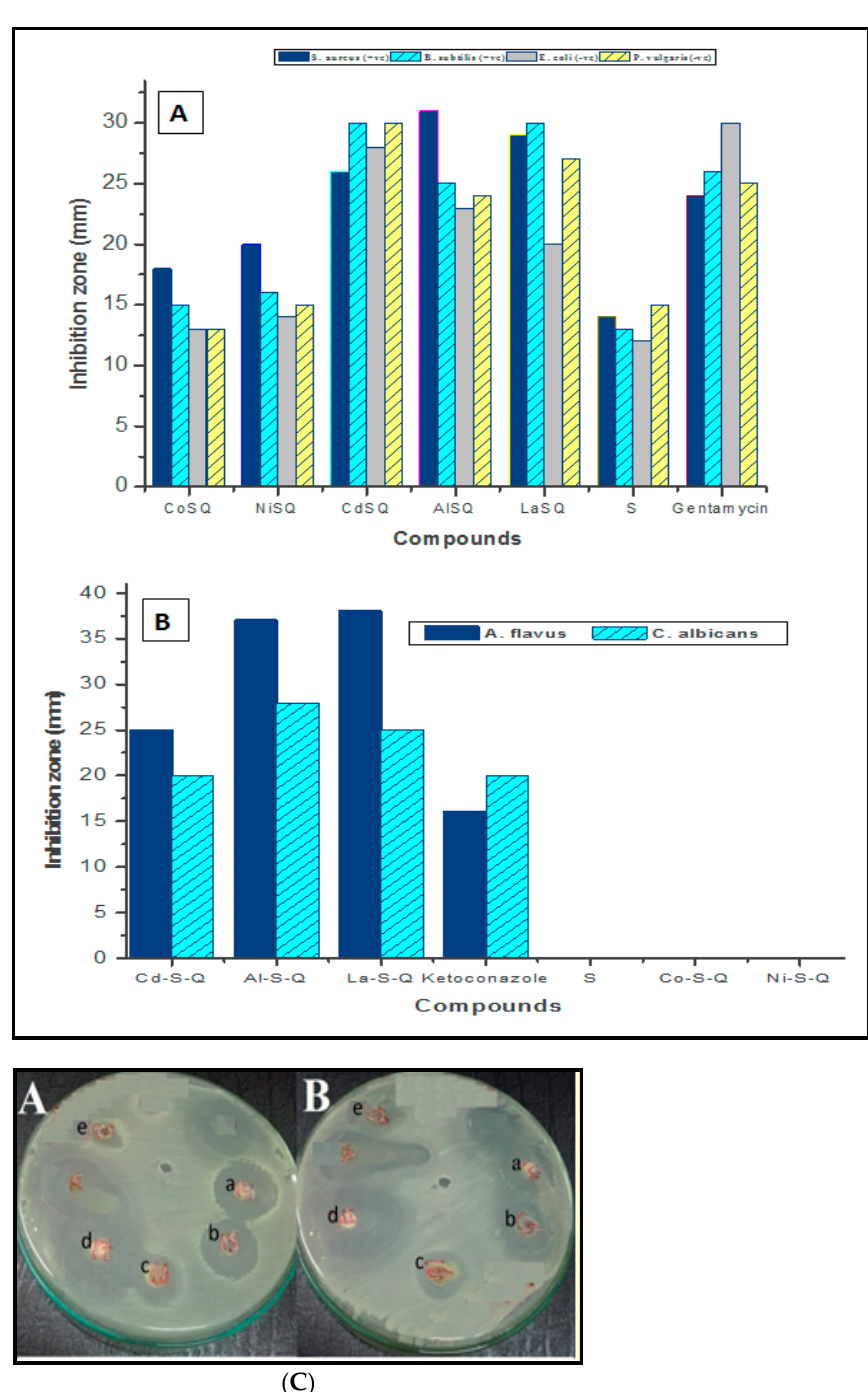
Figure 10. Graph showing the comparative ( A ) antibacterial activity of MSQ metal complexes against gentamycin as reference drug and ( B ) antifungal bioassay of MSQ metal complexes against ketoconazole at concentration of 10 mg mL − 1 as reference drug. ( C ) Inhibition zone of MSQ metal complexes against ( A ) Gram-positive bacteria B. subtilis (+ve) and ( B ) Gram-negative bacteria P. vulgaris ( − ve). (a) LaSQ, (b) AlSQ, (c) NiSQ, (d) CdSQ, (e) S at 10 mg/mL.